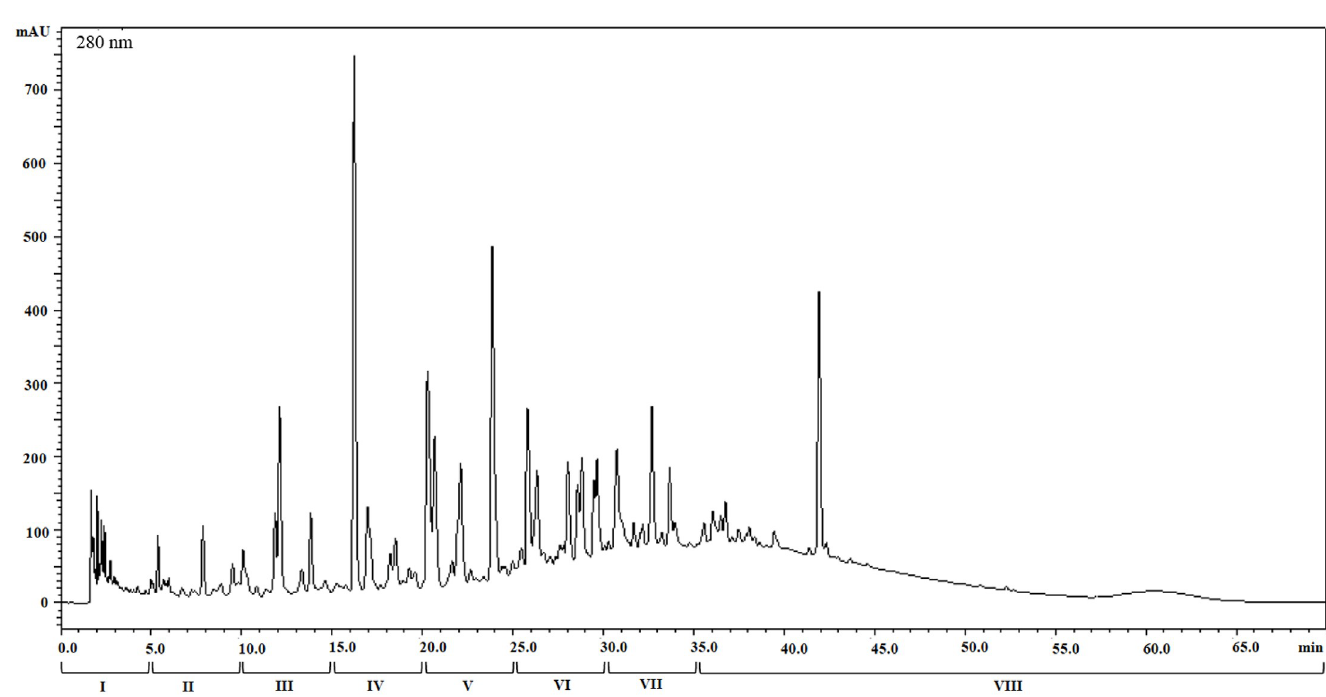
Fig 6. Chromatogram of HyE-Ov. Representative UV-visible absorption chromatographic profile of HyE-Ov obtained by HPLC-DAD analysis at 280 nm (absorption wavelength of phenolic acids) was reported.